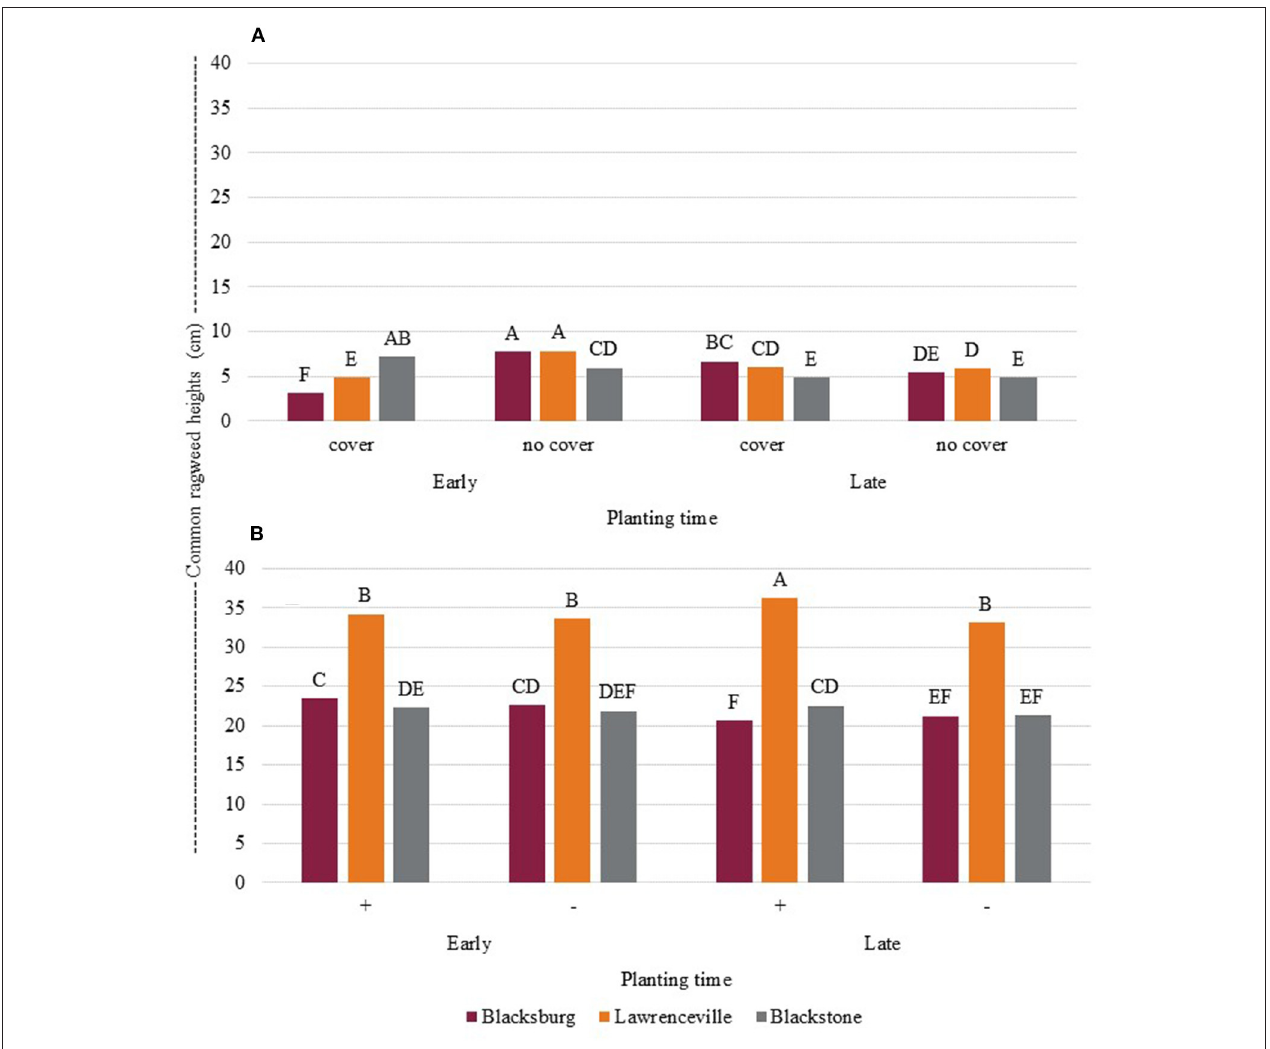
FIGURE 6 | Common ragweed heights (A) at preplant herbicide application in year 2 of the experiment by location, planting time, and location and (B) at POST application in the second year of the experiment by location, planting time, and HWSC. Means are considered statistically different when they do not share a letter according to Fisher’s Protected LSD ( P = 0.05)